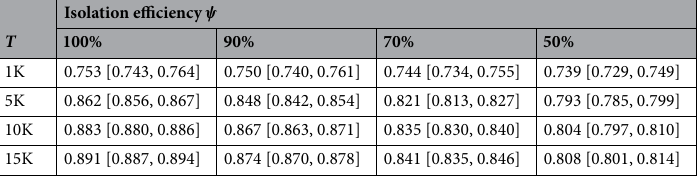
Table 5. Effect of isolation efficiency on the mean and range of f S .